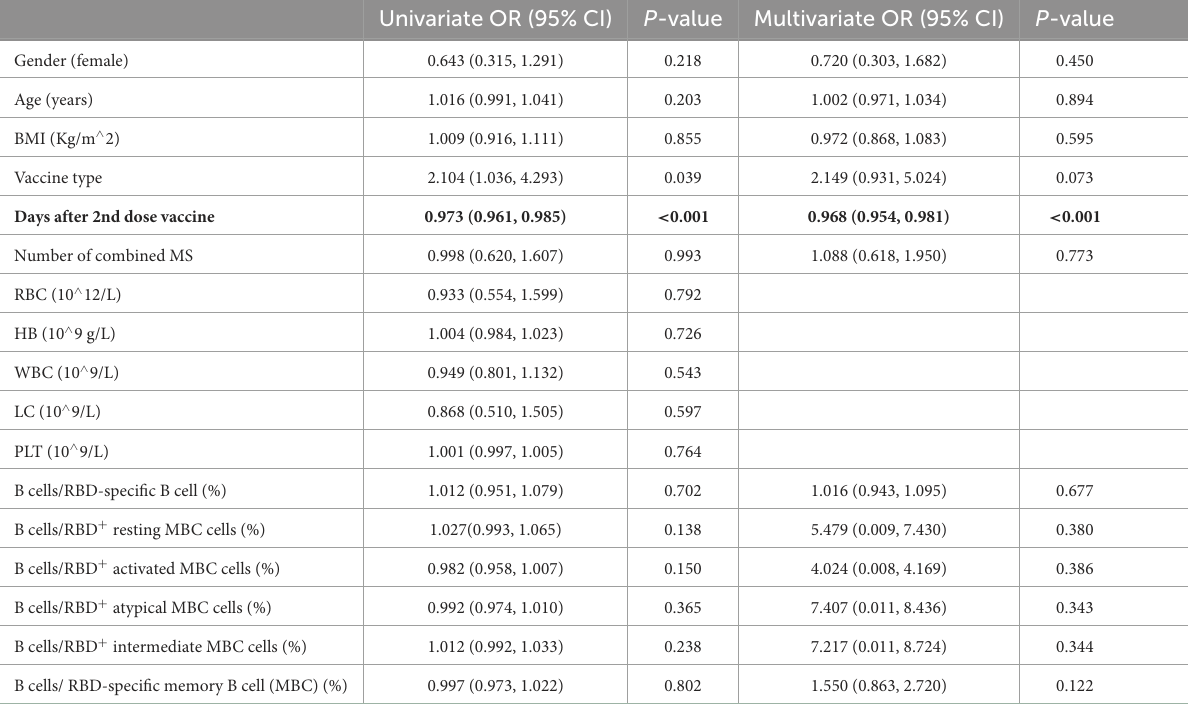
TABLE 3A Univariate and Multivariate analyses for anti-RBD-IgG in MS patients. Univariate OR (95% CI) P -value Multivariate OR (95% CI) P